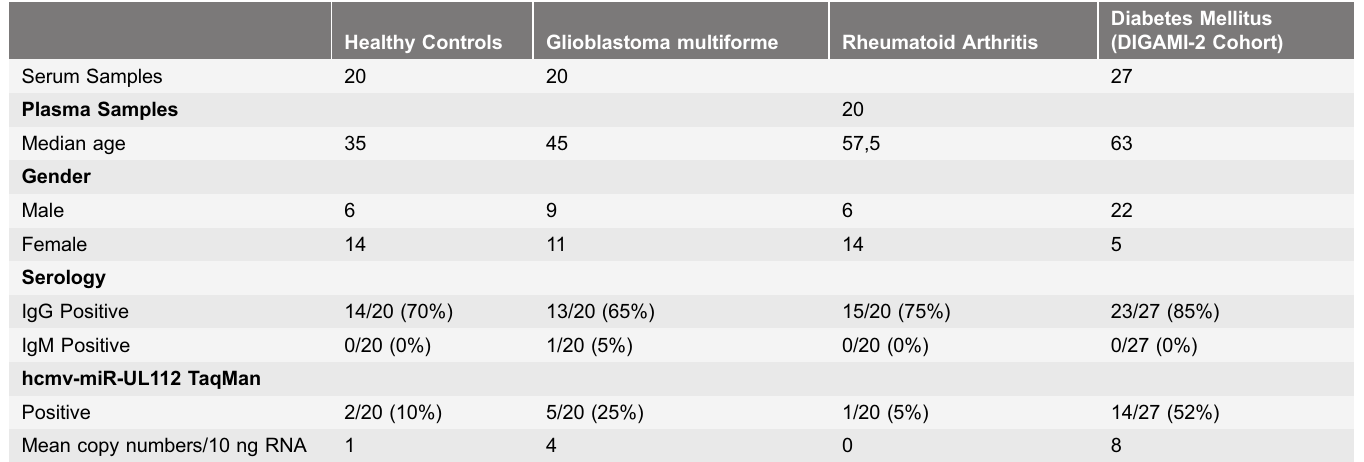
Table 1. Patient characteristics and summarised results.